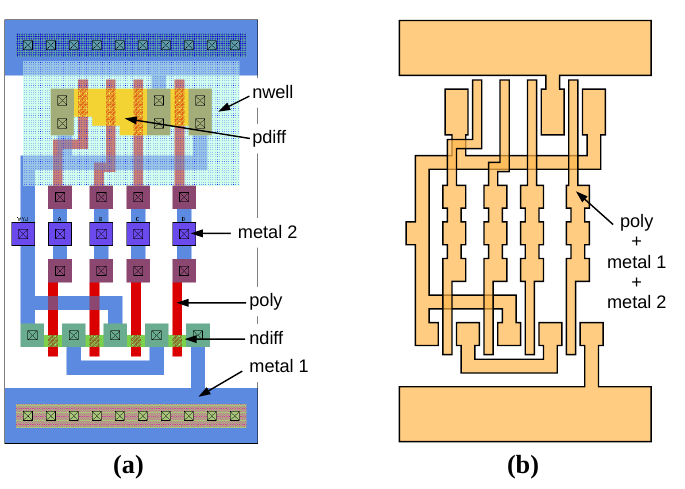
Figure 1. One of the logic gates analyzed in this work: ( a ) its full layout and ( b ) its nets after